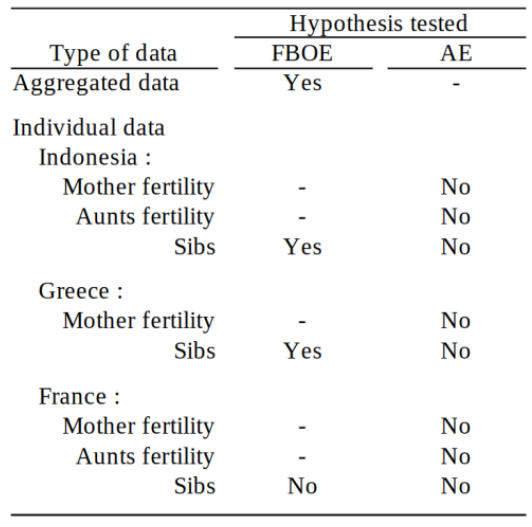
Table 4. Results of the various tests for detecting the presence of FBOE or AE in the different datasets considered. A dash indicates that the hypothesis could not be